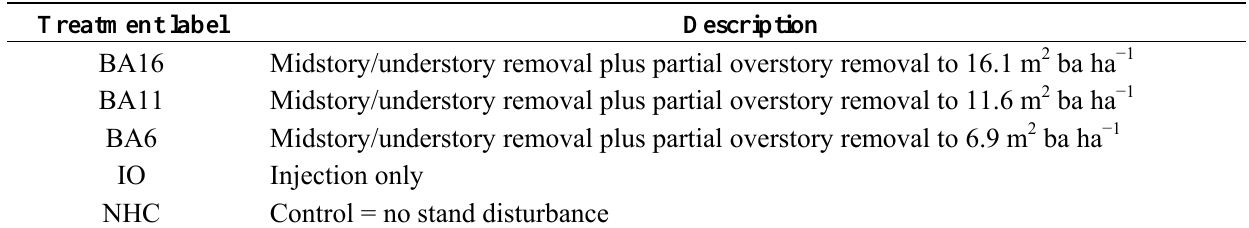
Table 1. Experimental treatment labels and descriptions utilized in the